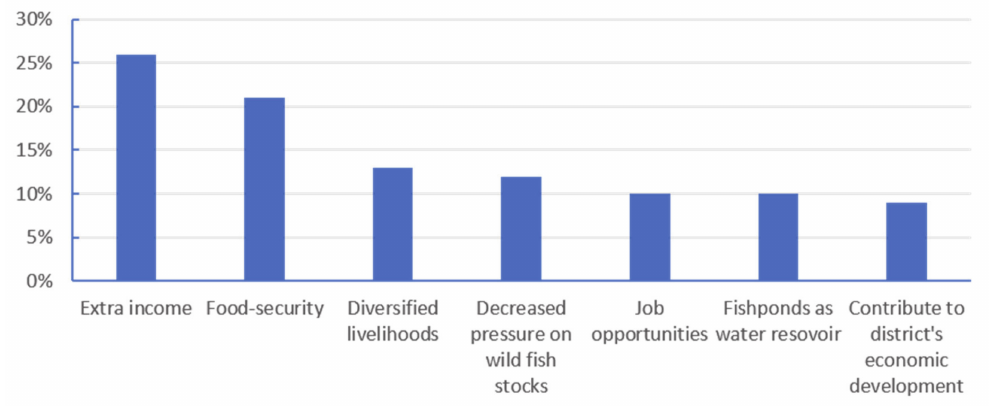
Figure 11. The relative importance of benefits from fish pond farming as ranked by 16 regional fisheries officers in